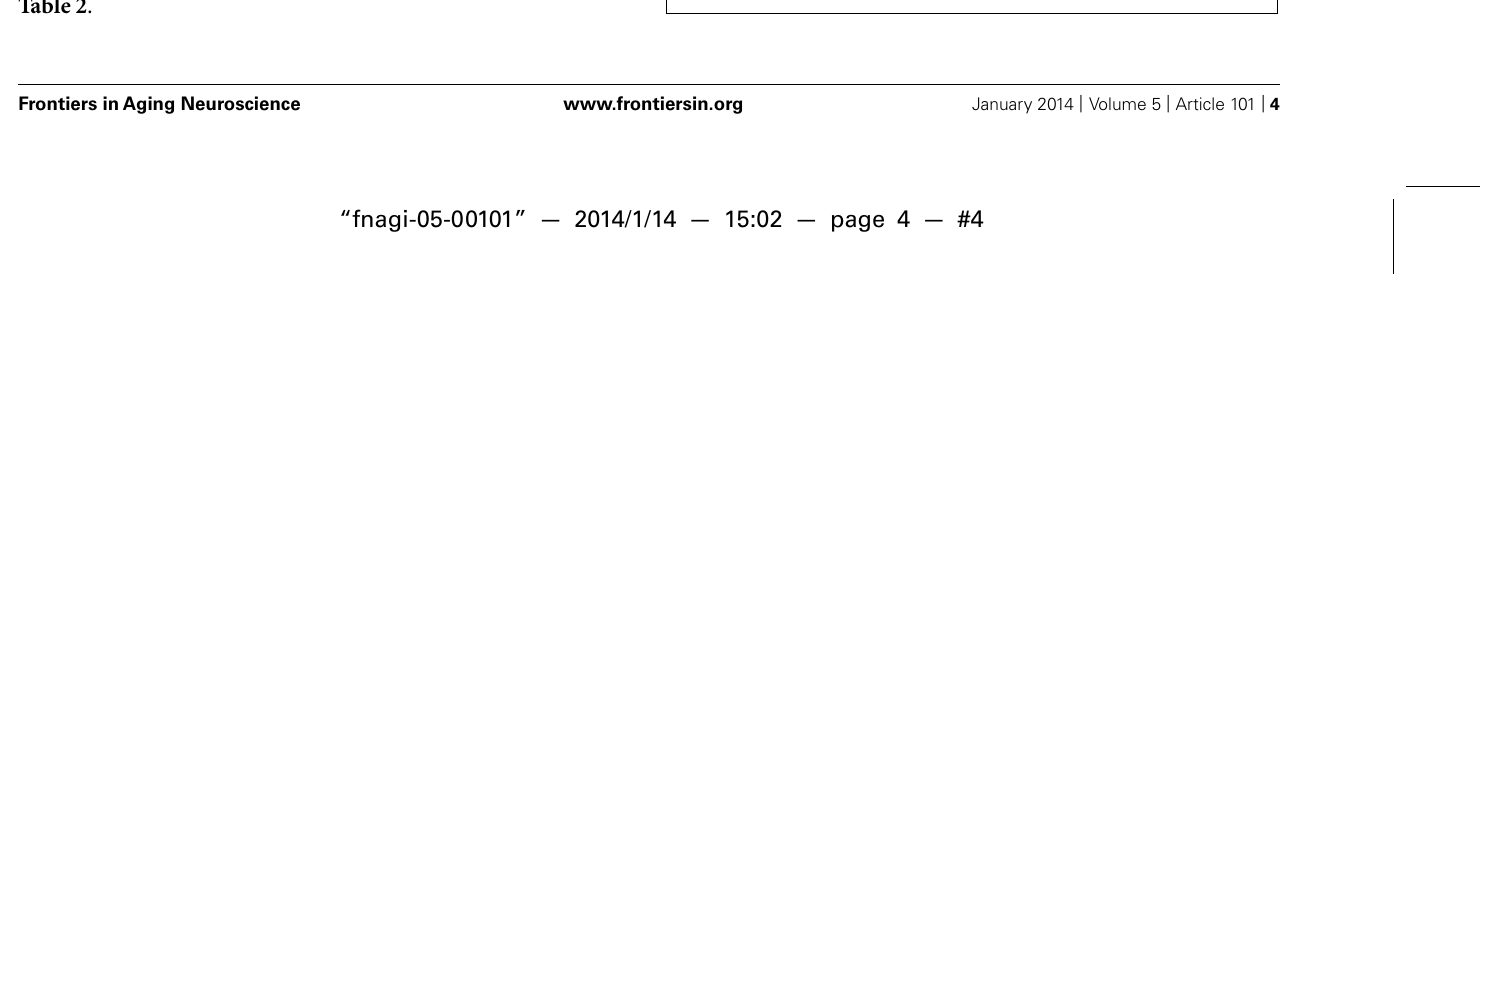
FIGURE 4 | Scatterplot of target detection performance depending on age. Each subjects’ performance is shown with circles, linear broken-line regression with colored solid lines, and the 90% confidence interval is shown with dotted lines and the polynomial regression as a solid black line. (A) Performance at ε H = 10 ◦ . (B) Performance at ε H = 30 ◦ . (C) Performance at ε H = 50 ◦